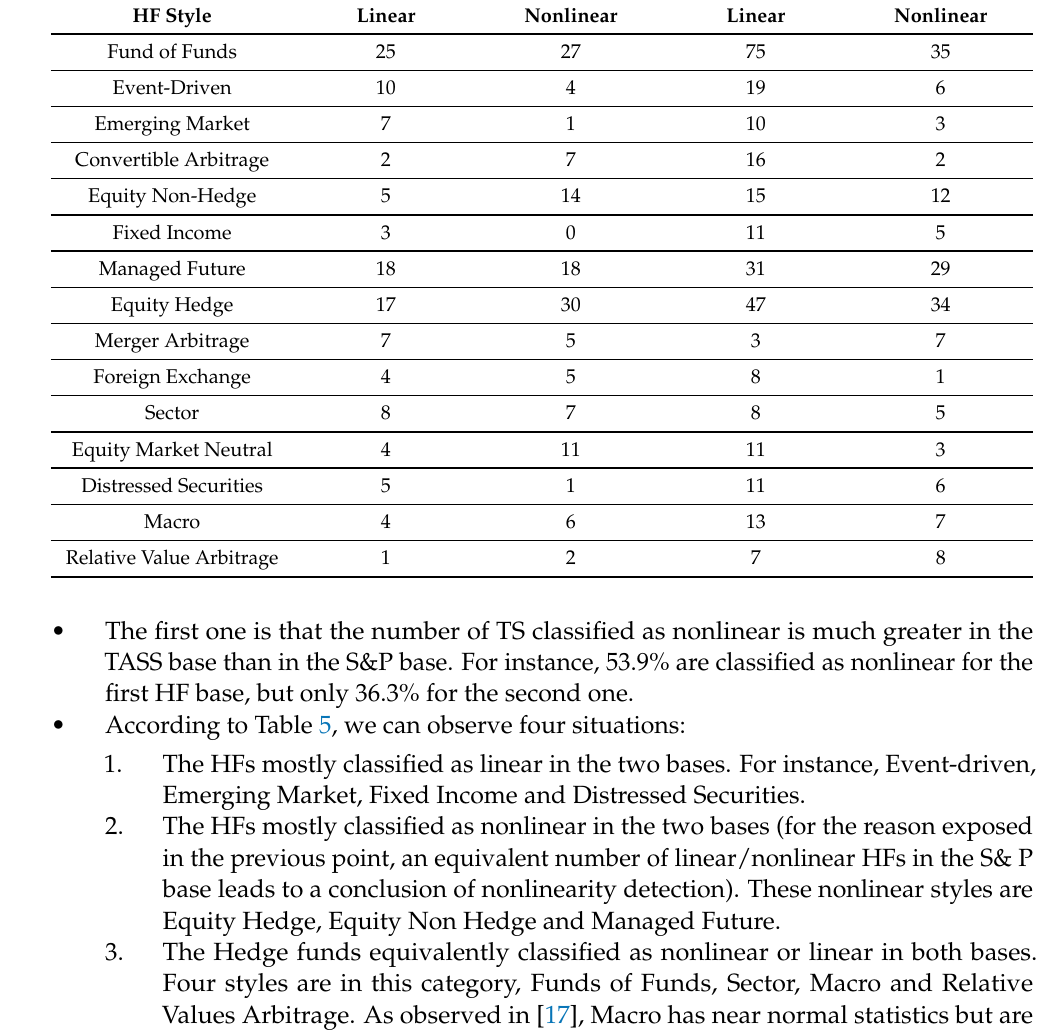
Table 5. Classification of Hedge funds according to the decision rule of nonlinearity for the TASS base (second and third column) and the S&P base (fourth and fifth